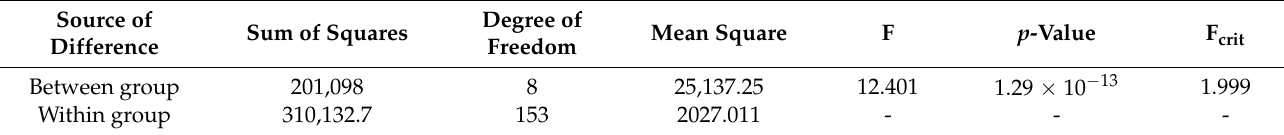
Table 5. The results of the ANOVA of the surface deflection.